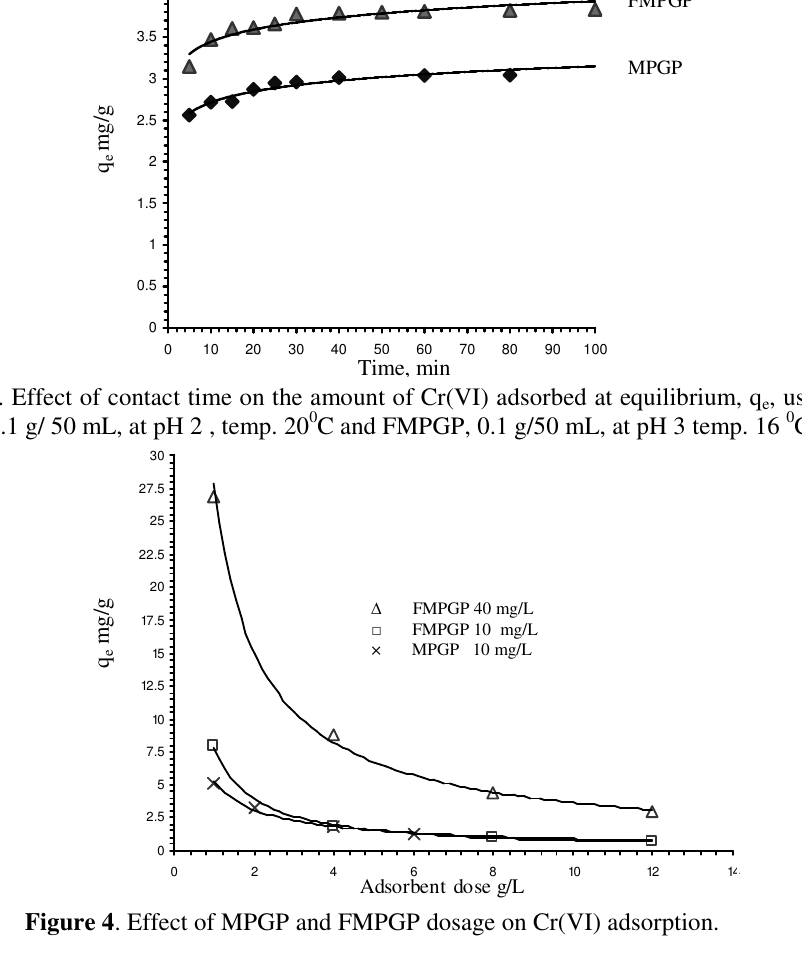
Figure 4 . Effect of MPGP and FMPGP dosage on Cr(VI)